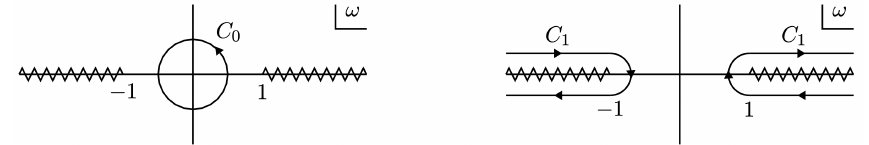
around the origin can be deformed into two contours C 0